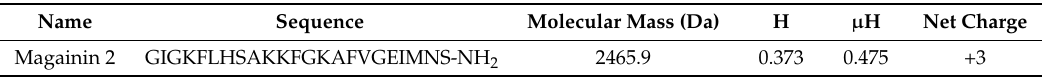
Table 1. Amino acid sequence and properties of magainin